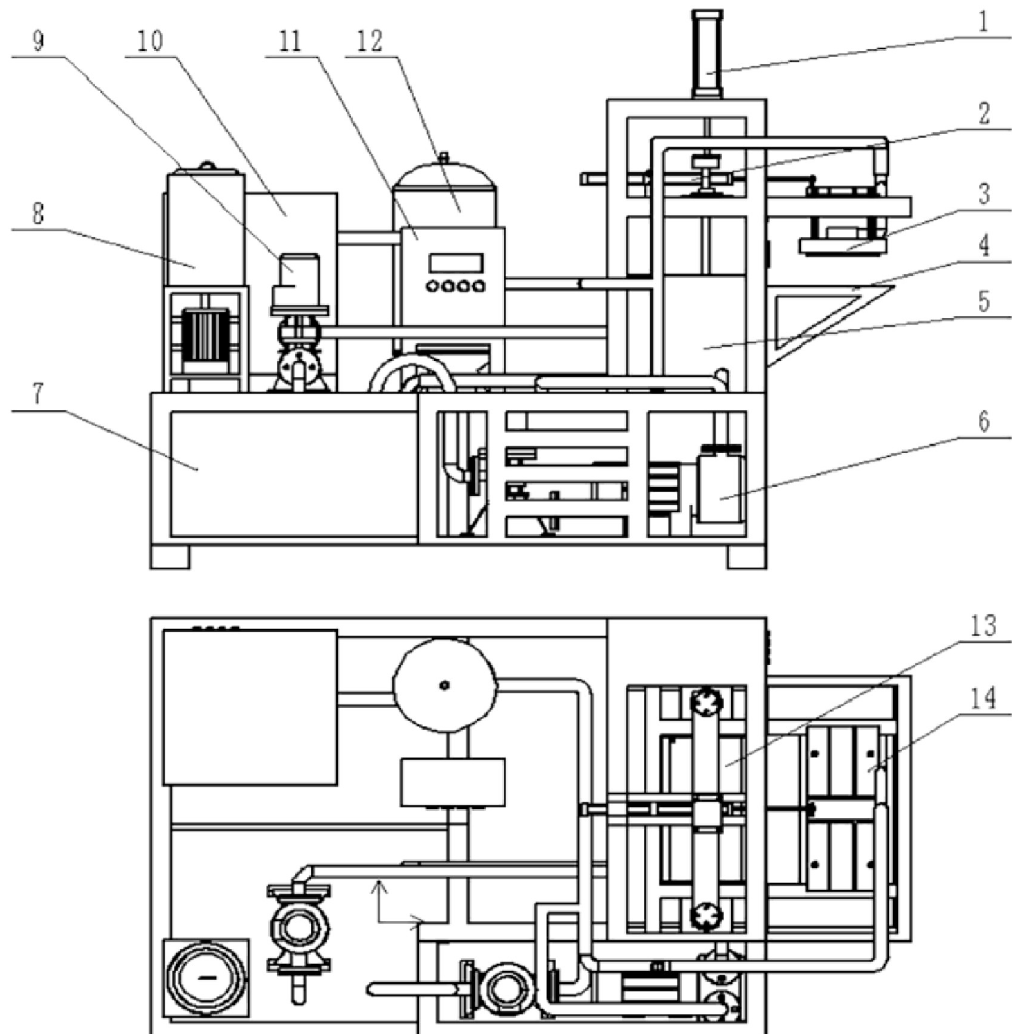
Fig 1. Structural schematic diagram of the pneumatic molding machine. 1. Vertical cylinder 2. Horizontal cylinder 3. Deputy mold 4. Objective table 5. Slurry storage tank 6. Water-ring vacuum pump 7. Pulping tank 8. Mixing tank 9. Water pump 10. Air compressor 11. Control cabinet 12. Gasholder 13. Main mold 14. Mold bracket.